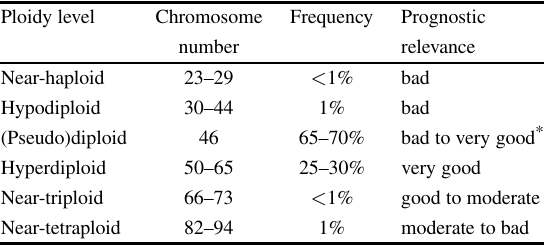
Classification of BCP-ALL according to the ploidy level Ploidy